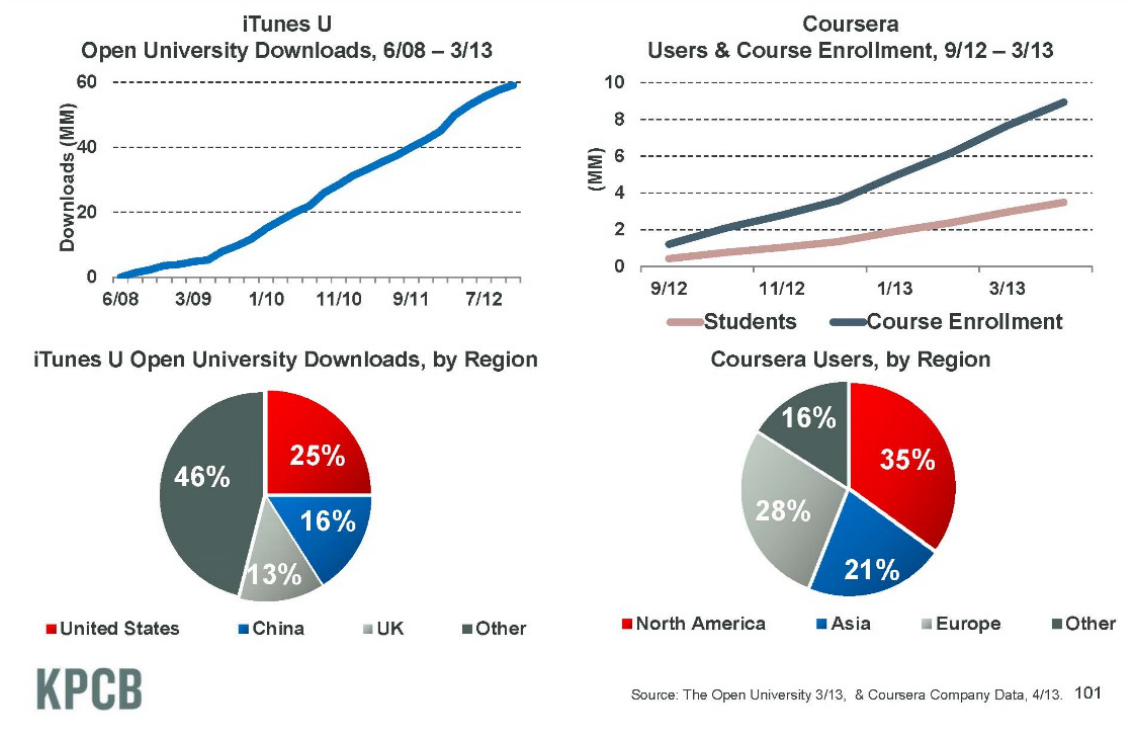
Figure 1. Freely available educational materials like video lectures on iTunes U and YouTube (not shown here but growing equally rapidly) are democratizing education. Within the private sector, Coursera has the largest, most rapidly growing enrollments (Meeker and Wu, Internet Trends, D11 Conference, May